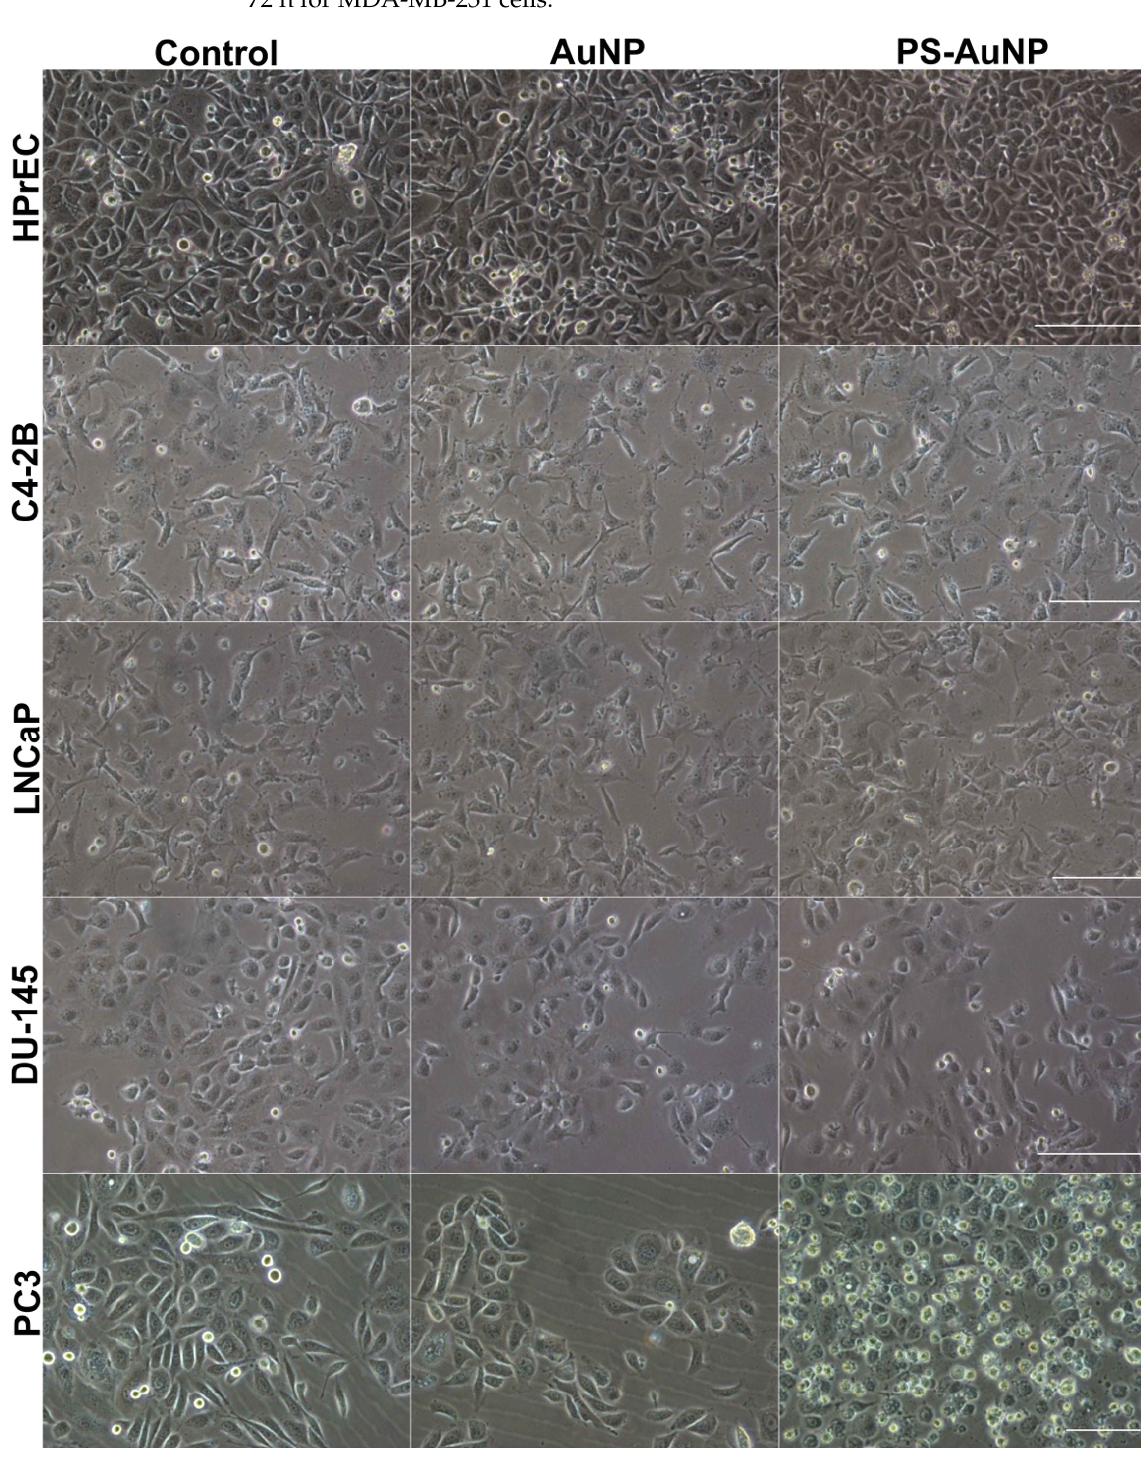
Figure 3. PS-AuNPs induce significant morphological changes in prostate cancer (PC3) cells compared to PBS-challenged cells (control) and the normal prostate (HPrEC) cell line. From top to bottom rows, light microscopy of the cell morphology of HPrEC normal prostate cell line and the prostate cancer cell lines C4-2B, LNCaP, DU-145, and PC3. The left column shows cell lines challenged with PBS; the central column shows cell lines challenged with AuNP; and the right column shows cell lines challenged with PS-AuNP. Scalebar equivalent to 50 µm.